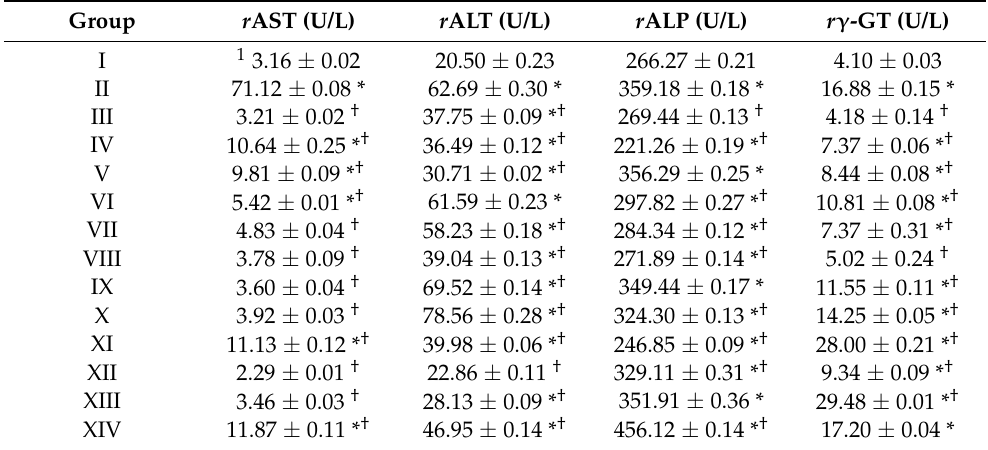
Table 4. Catalytic activities of serum biochemical markers within the rats exposed to different doses of N. cataria extracts and CCl 4 .